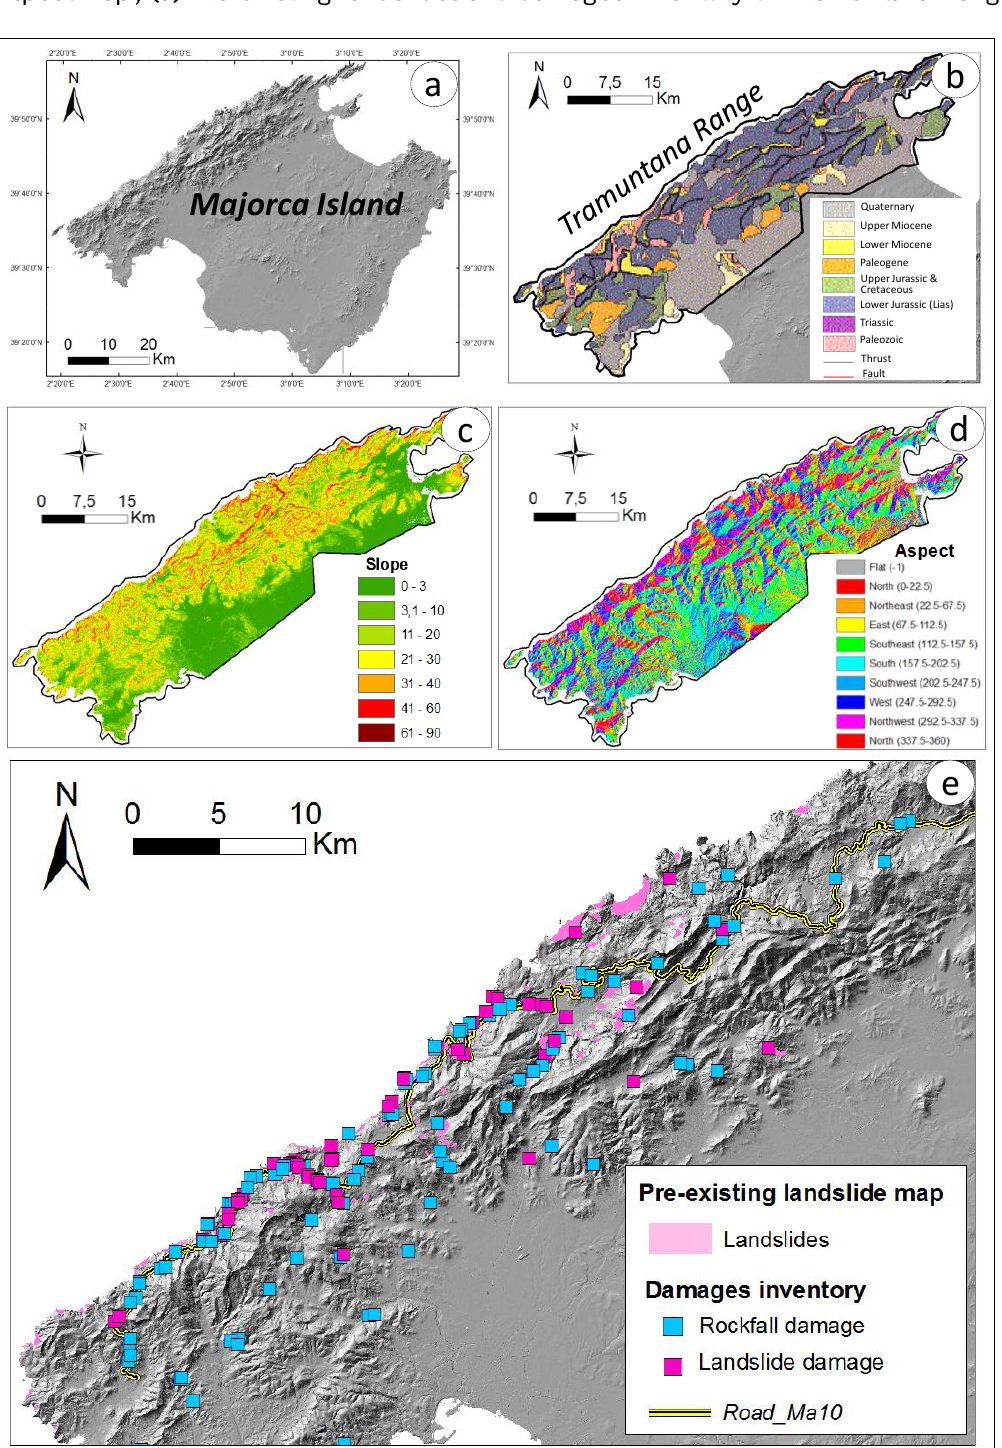
Figure 1. Background and pre-existing information of the study area: ( a ) Geographical location; ( b ) Geological setting of Tramuntana Range study area; ( c ) Slope map; ( d ) Aspect map; ( e ) Pre-existing landslides and damages inventory of Tramuntana